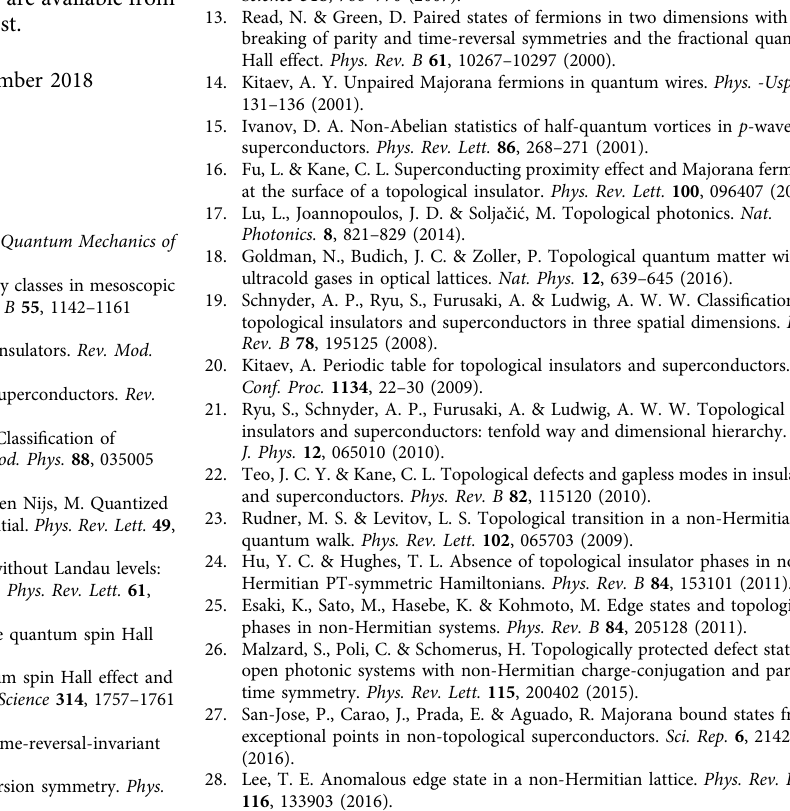
The data that support the fi ndings of this study are available from the corresponding author on reasonable request.